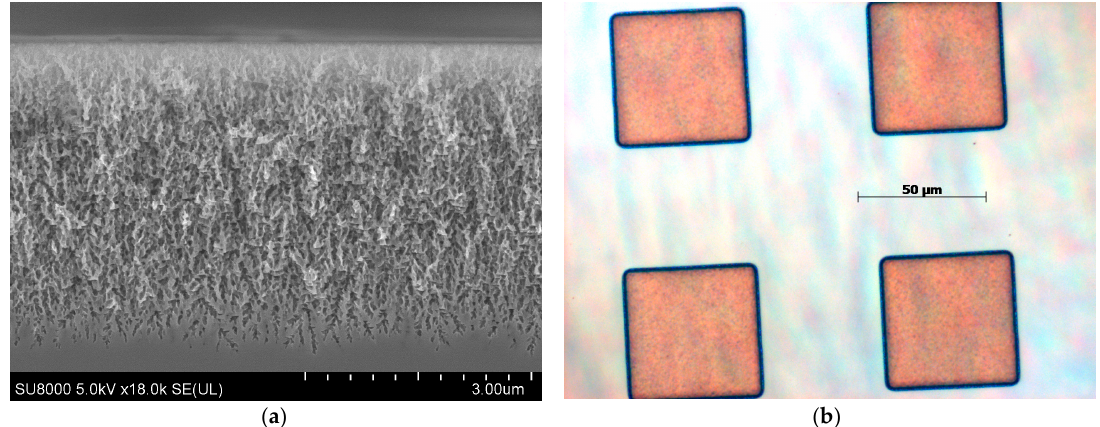
Figure 2. Porous SiC generated with MAPCE after Pt removal with aqua regia; ( a ) Cross sectional SEM micrograph; ( b ) Top down view optical microscope image. The orange areas indicate regions of pSiC surrounded by dense SiC.